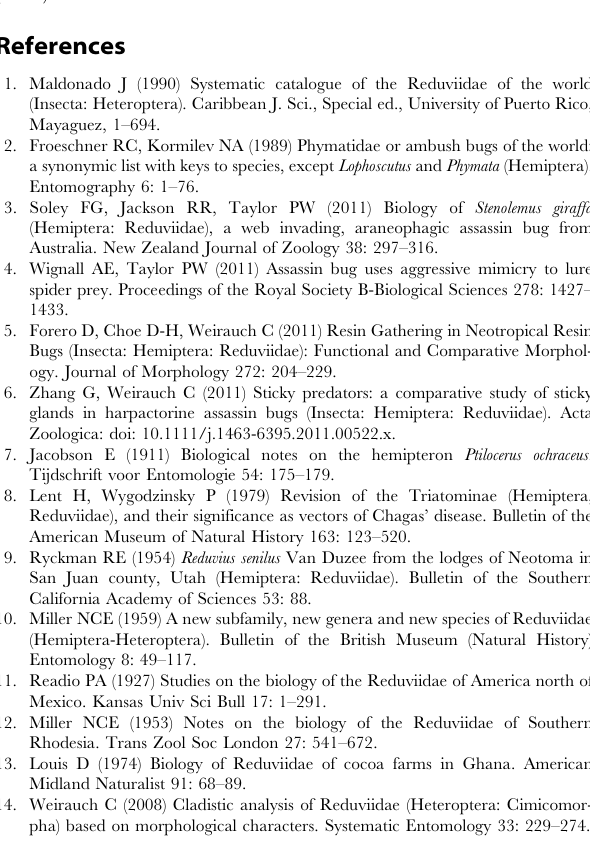
Table S1 Taxon list with ID numbers, depository information, GenBank accession numbers, Reduviinae clade classification, microhabitat and prey specialization coding with references and locality information. Footnote: * refers to dried museum specimens. Table S2 Summary of individual gene region and combined sequence lengths of dataset based on different alignment algorithms. Table S3 Table for bootstrap values of all subfamilies and Reduviinae clades based on different sequence alignment algorithms. Table S4 Fossil calibration table with fossil taxonomic information, locality, taphonomy, fossil age and age references. Table S5 Summary table of age estimates of selected reduviid clades with 95% highest probability density intervals. Table S6 Distant’s 1904 classification of Reduviinae (Acanthaspidinae) into six divisions. Table S7 Proposed clade-membership of Reduviinae genera. Footnote: genera in bold font represent genera included in present study, genera in regular font are genera absent